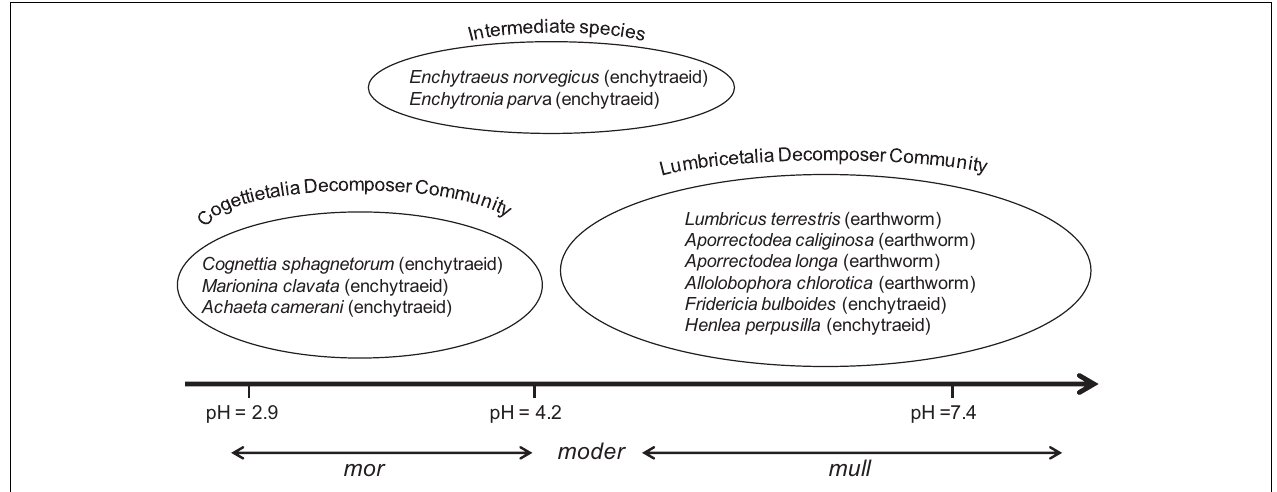
FIGURE 4 | Distribution of 4 earthworm and 5 enchytraeid species along a soil pH gradient (redrawn from Graefe and Beylich, 2003, with permission from Wageningen